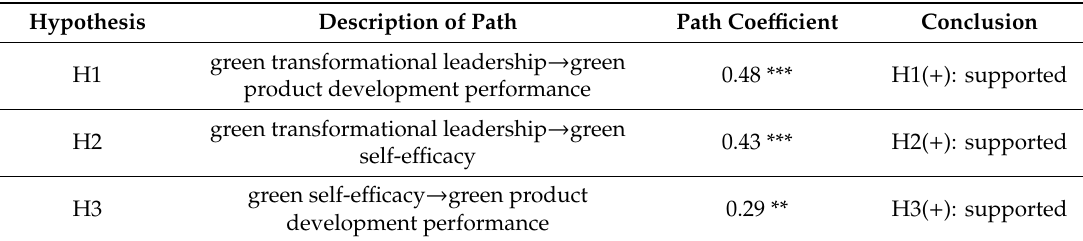
Table 3. Results of path coe ffi cient analysis.